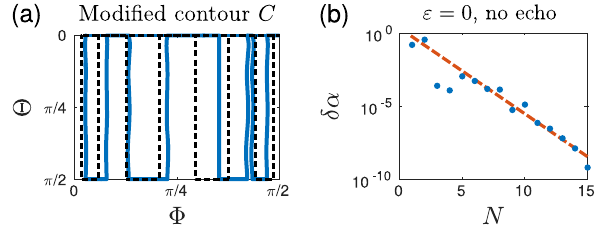
FIG. 8. Effect of cross-correlations between Φ and θ on the geometric decoupling scheme. (a) The modified protocol (solid blue) described by the error model [Eq. (G2)] in comparison to the perfect implementation (dashed black). (b) Decay of the phase error in terms of the number of turns N . The red dashed line shows an exponential fit starting at N ¼ 5